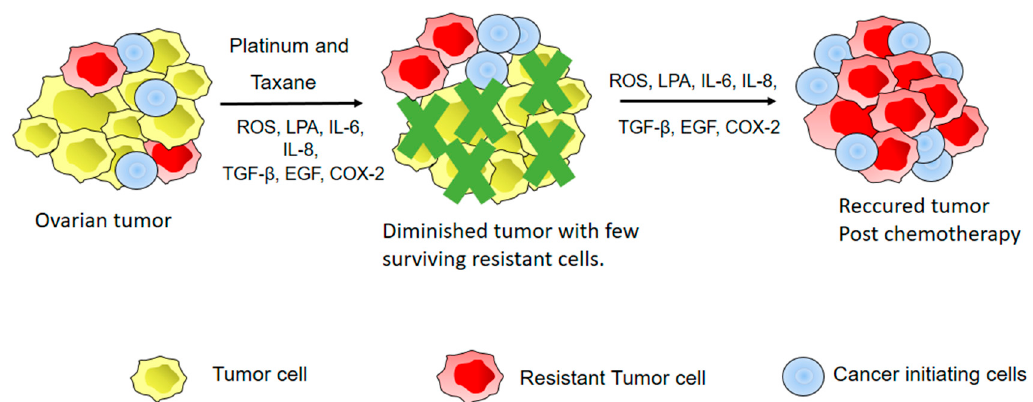
Figure 3. Inflammatory mediators contribute to chemoresistance of EOC. A combination of platinum and taxane drugs is currently used as chemotherapy for OC. ROS, Lyophosphotidic Acid (LPA), cytokines, and growth factors like TGF- β and EGF increase tumor cell survival by upregulating antiapoptotic genes, by stimulating stemness and proliferation of cancer initiating cells, by increasing repair of damaged DNA, or by increasing efflux of the drug. The resistant tumor cells and the cancer initiating cells can then proliferate under the influence of growth factors and cytokines resulting in a recurrent chemoresistant tumor.